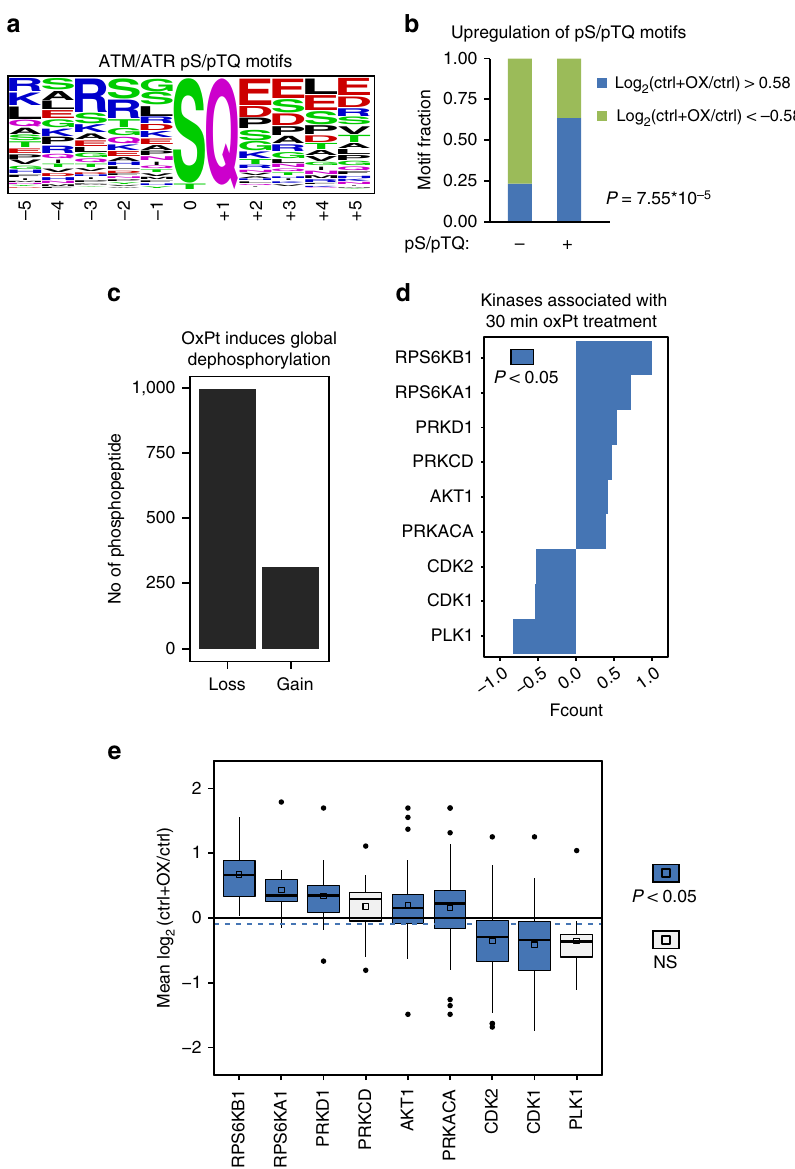
Figure 8 | The phosphoproteome response to oxPt in CRC cells. ( a ) A sequence logo was generated based on 205 detected phosphopeptides with potential ATM/ATR phosphorylation sites (pS/pTQ). ( b ) Fisher’s exact test on counts of dysregulated (log 2 (ctrl þ OX/ctrl) ± 0.58 and false discovery rate (FDR) r 0.1) phosphopeptides revealed significantly increased upregulation of pS/pTQ motifs after oxPt treatment. ( c ) The number of altered phosphopeptides after 30min of 16 m M oxPt treatment were counted and grouped into peptides with decreased phosphorylation (log 2 (ctrl þ OX/ctrl) o 0.58) (‘Loss’) and increased phosphorylation (log 2 (ctrl þ OX/ctrl) 4 0.58) (‘Gain’). ( d ) KSEA was done on log 2 (ctrl þ OX/ctrl) ratios (as described in Fig. 5). Only substrate groups with indication of altered activities after oxPt exposure are shown (* P r 0.05, hypergeometric test). ( e ) Mean log 2 phosphorylation ratios for the nine substrate groups in d ; (coloured boxes indicate P r 0.05, z -test). NS, not